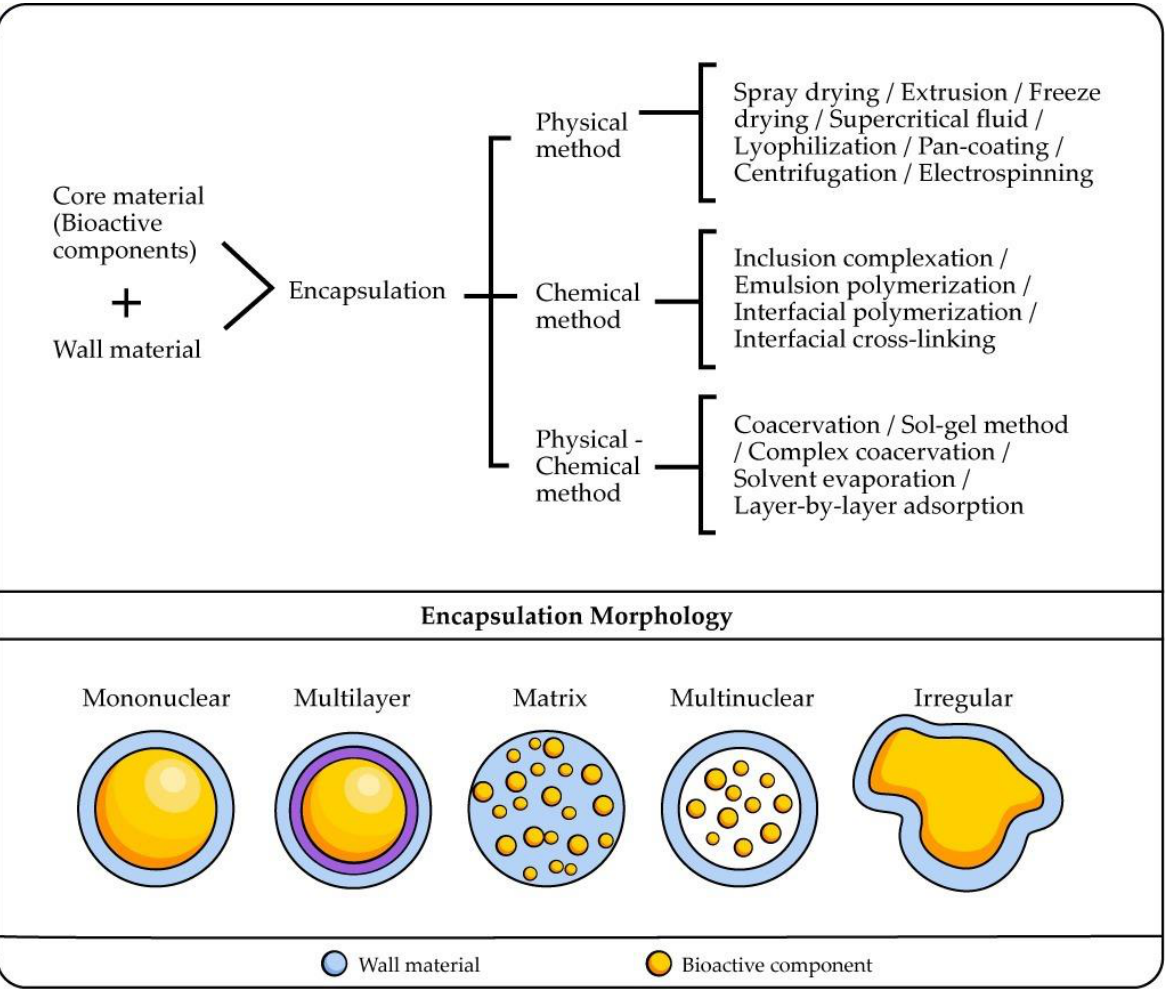
Figure 1. Encapsulation and morphology of microcapsule.